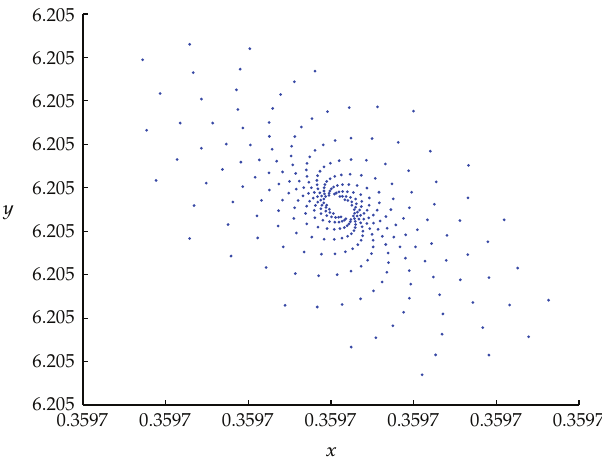
Figure 19: Phase portrait for the system (cid:3) 2.2 (cid:4) before the NS point (cid:3) a (cid:8) 3 . 5, b (cid:8) 0 . 2, and d (cid:8) 2 . 78 (cid:4) .